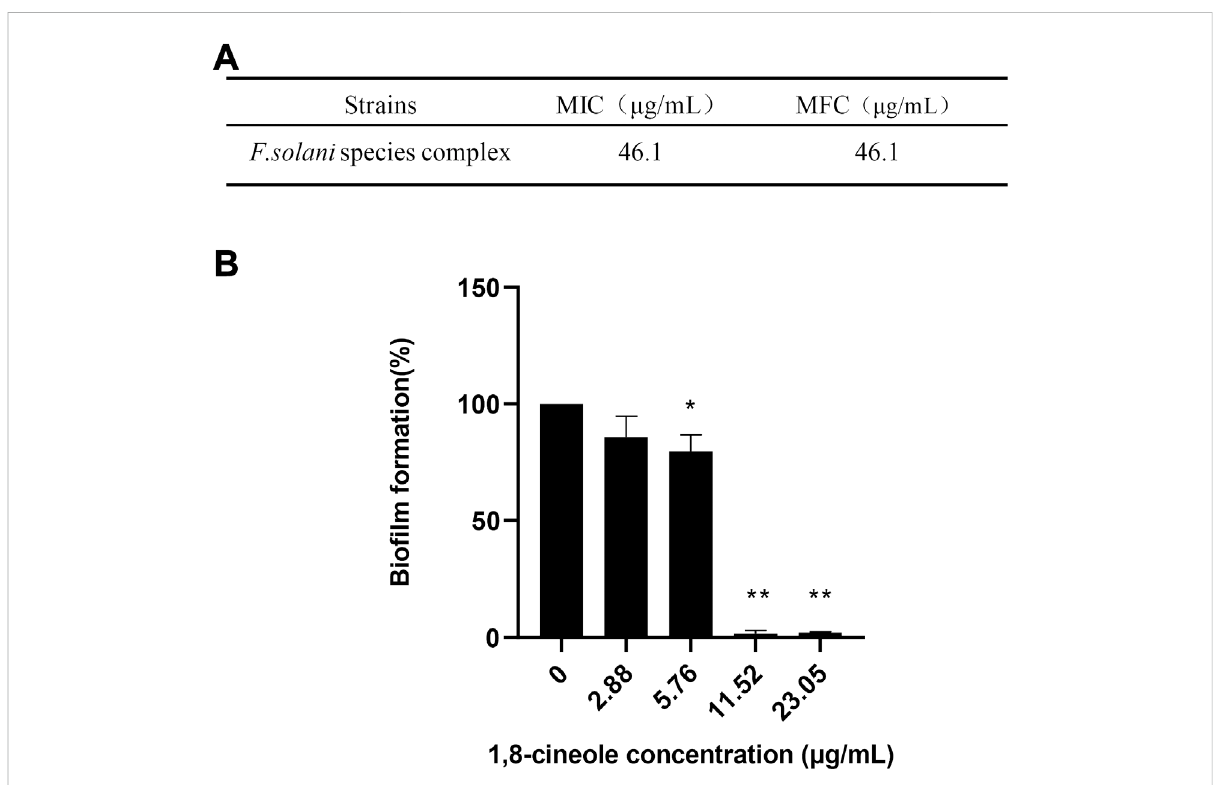
FIGURE 1 1,8-cineole inhibits F. solani species complex bio fi lm formation in vitro . Bio fi lm formation was evaluated using an XTT reduction assay, and the results are presented as the percent of 1,8-cineole treated bio fi lm relative to control bio fi lm formed without treatment. (A) The MICs and MFCs of 1,8-cineole against F. solani species complex (46.1 – 2.88 μ g/ml). (B) Effects of different concentrations of 1,8-cineole on bio fi lm formation. The results represent means ± standard deviations for three independent experiments. *, p < 0.05; **, p <